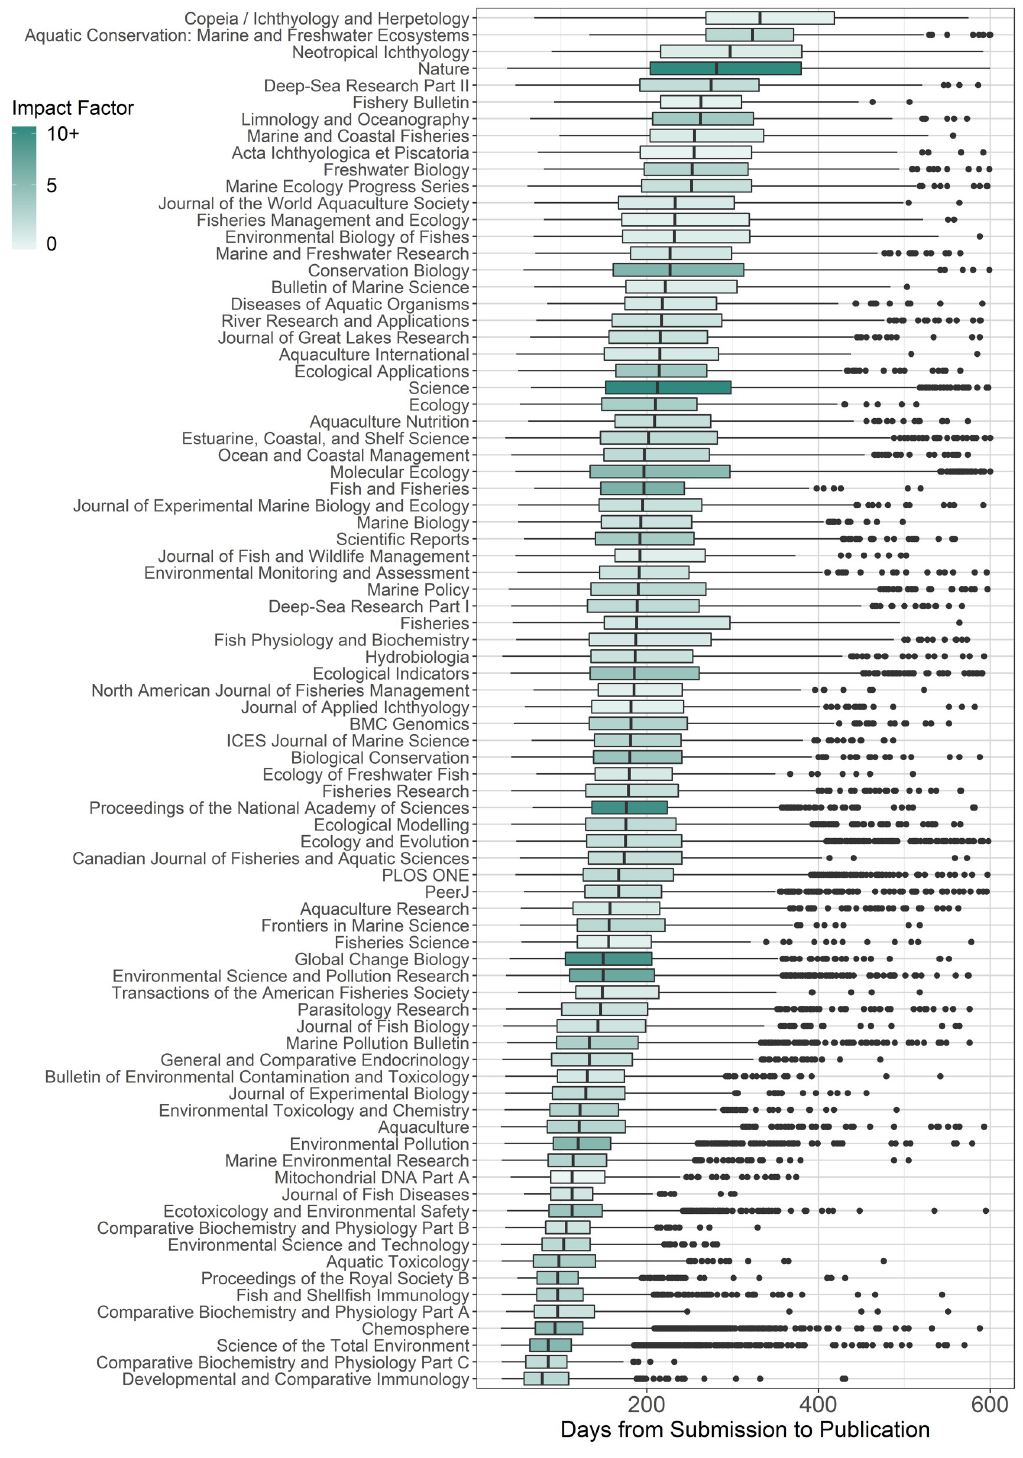
Fig 3. Boxplots showing days from submission to publication for 82 journals that publish papers in fisheries and related topics organized in descending order of medians. Central vertical lines represent medians, hinges represent the 25 th and 75 th percentiles, and lower and upper whiskers extend to either the lowest and highest values respectively or 1.5 � the inter-quartile range. Black dots represent papers that were outside 1.5 � the inter-quartile range. Boxes are shaded to correspond with 2018 Impact Factor, where darker green represents higher